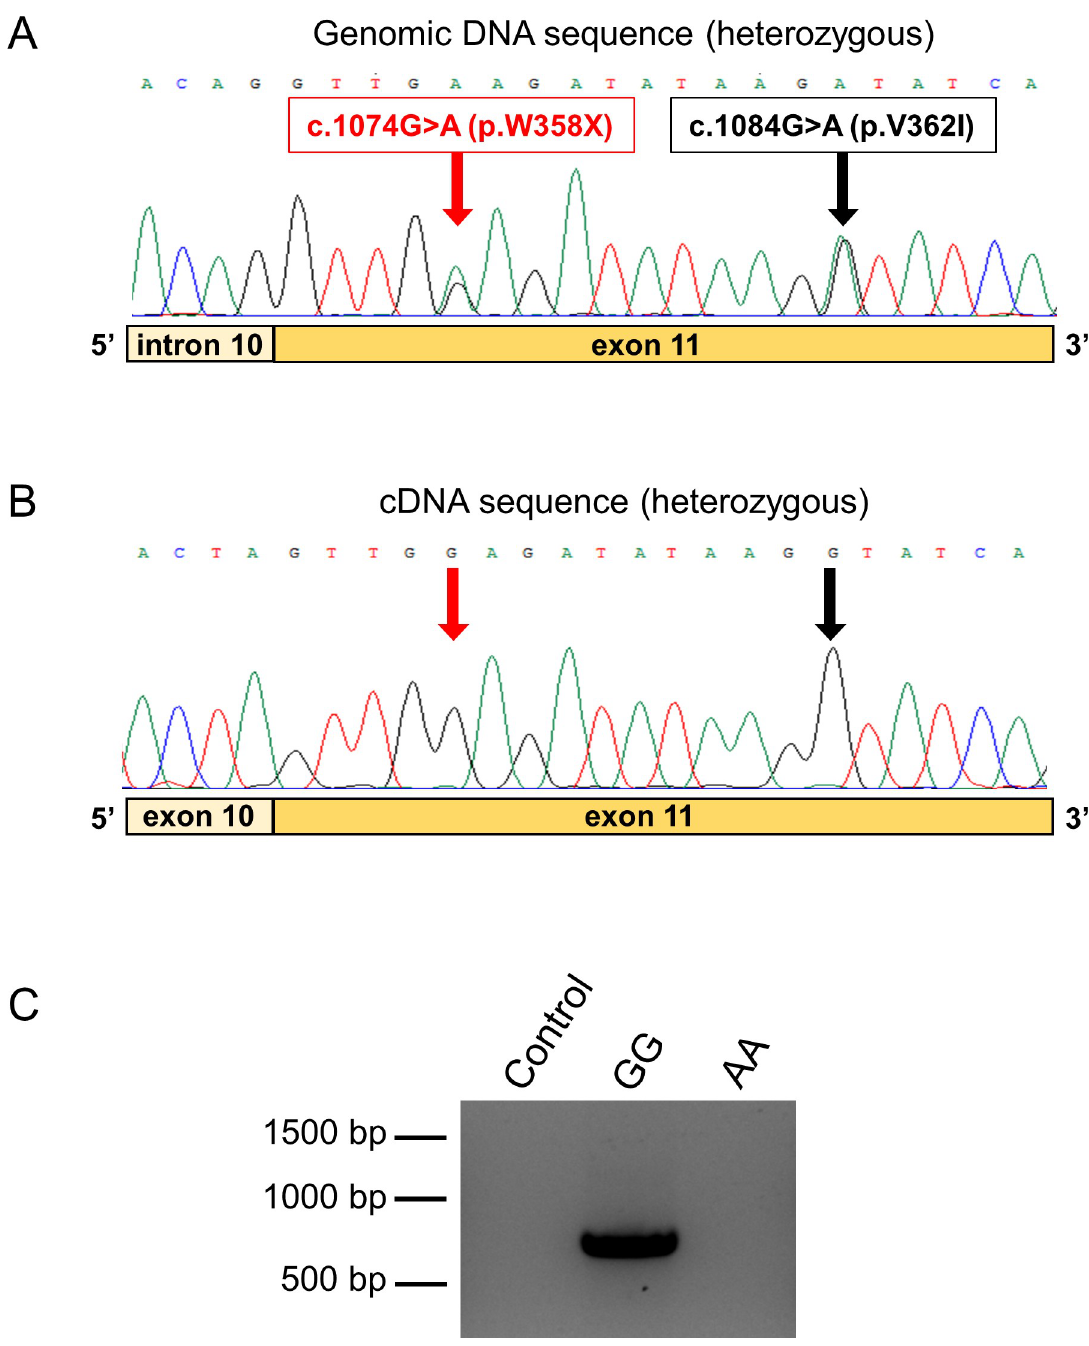
Fig 2. Expression of the PNLIPRP2 p.W358X truncation variant. A , Electropherogram of the genomic DNA sequence of a heterozygous carrier showing the double signal at the position of variants p.W358X and p.V362I. B , Electropherogram of the pancreatic cDNA sequence of the same heterozygous subject. Note the absence of the signal corresponding to the minor truncation allele at the position of the variants. C , Agarose gel electrophoresis of PCR amplicons from pancreatic cDNA samples of subjects with homozygous A (minor truncation allele) and G (full-length allele) genotypes. Control reaction was performed with no added